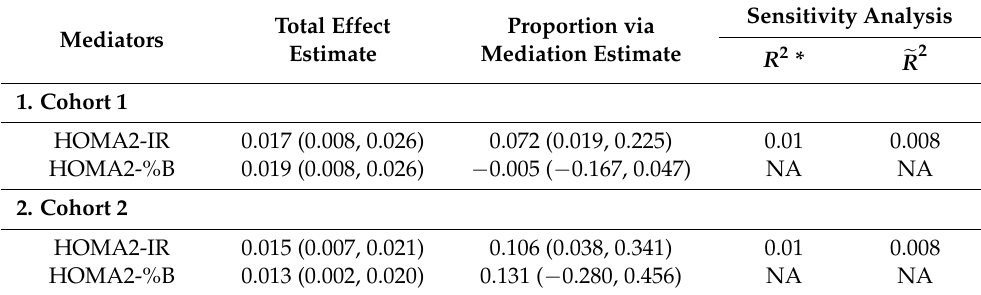
Table 6. The effect (95% Confidence interval) of tertiles of low-carbohydrate, high-fat and high-protein diet scores on type 2 diabetes with mediation of biomarkers in the population consuming extra calories of the Harbin People’s Health Study (Cohort 1, 2008–2012) and Harbin Cohort Study on Diet Nutrition and Chronic Non-Communicable Diseases (Cohort 2,